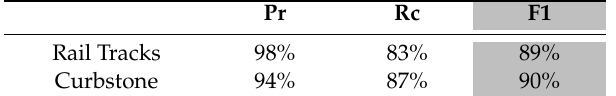
Table 5. Evaluation results for disrupting object classes, rail tracks, and curbstone. Table 6. Evaluation results for disrupting object classes, rail tracks, and